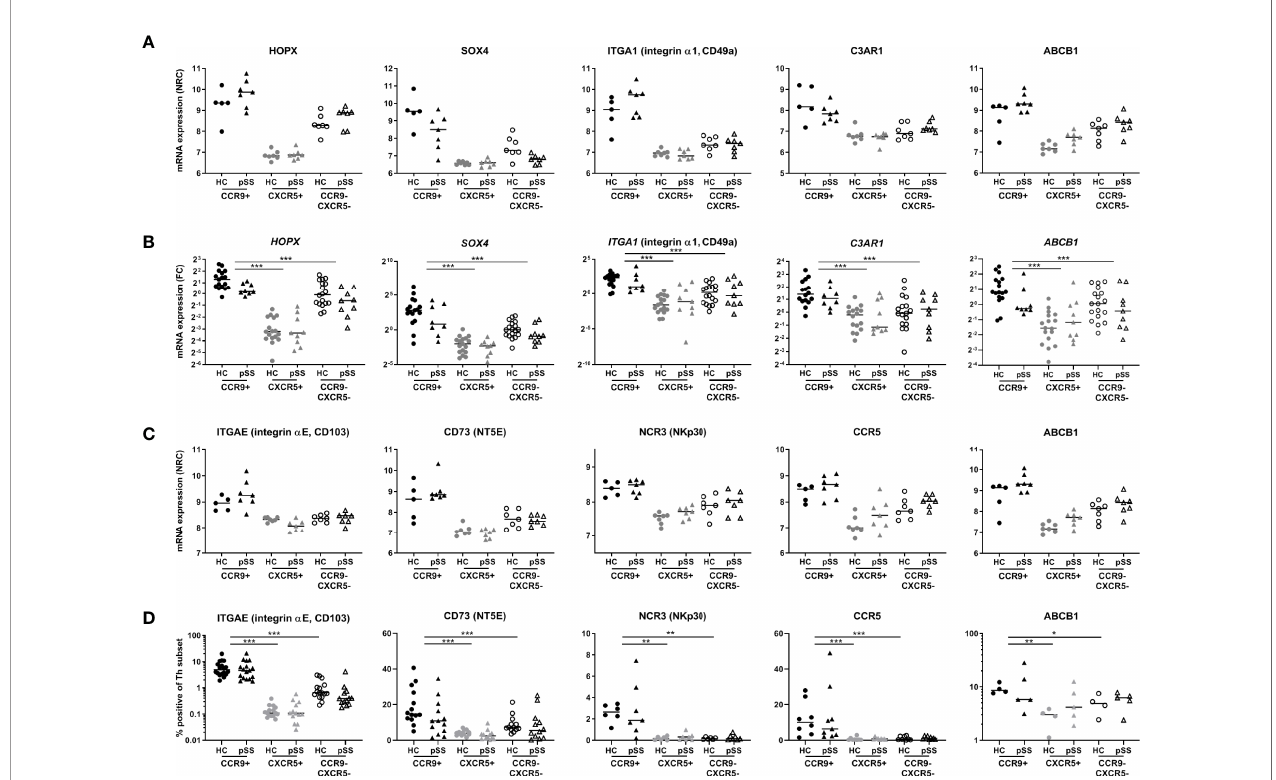
FIGURE 4 | Validation of selected target genes from the blue module in replication cohorts con fi rms differences between Th subsets, but not between HC and pSS patients. According to the criteria shown in Figure 3 and based on pathway enrichment analysis ( Figure 2 ) and literature, genes were selected from the blue module and were replicated by qPCR and fl ow cytometry. RNA sequencing data is shown in (A, C) , qPCR and fl ow cytometry data are shown in (B, D) , respectively. HOPX, SOX4, ITGA1, C3AR1 and ABCB1 were evaluated by qPCR in an additional replication cohort (B) . Genes encoding for surface proteins for which antibodies were available were replicated by fl ow cytometry: ITGAE (CD103), CD73 (NT5E), NCR3 (NKp30), CCR5 and ABCB1 (D) . NRC, normalized read counts; FC, fold change, DN HC mean is set at 1. *, **, *** indicates statistical signi fi cance of p < 0.05, 0.01, 0.001,